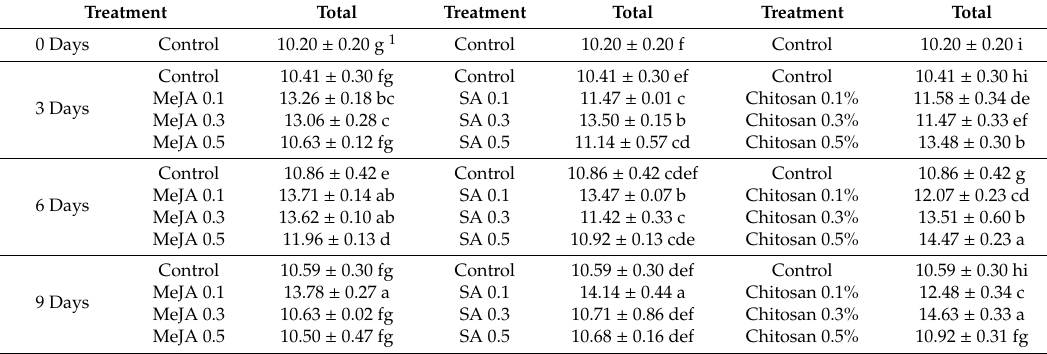
Table 2. The content of total phenolic compounds (mg / g dry wt.) in P. brachycarpa Nakai under di ff erent elicitor